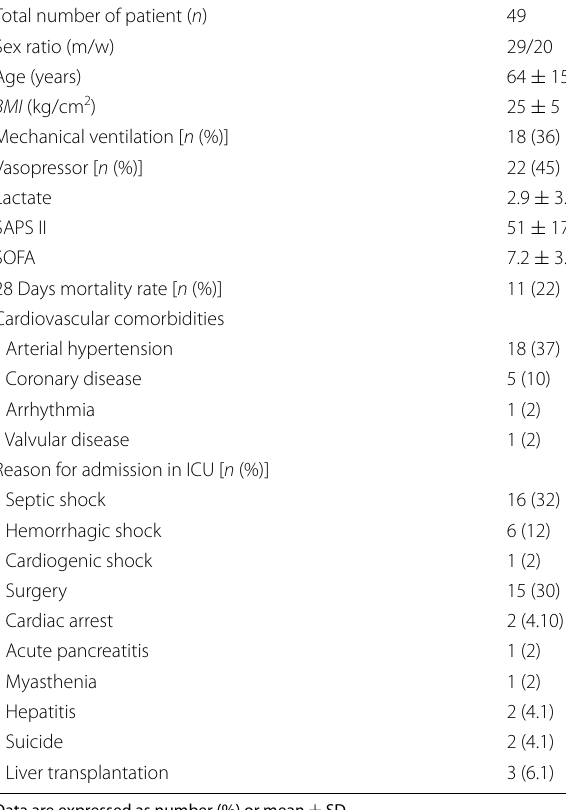
Table 1 Clinical characteristics of study patients Table 2 Echocardiography and clinical data before